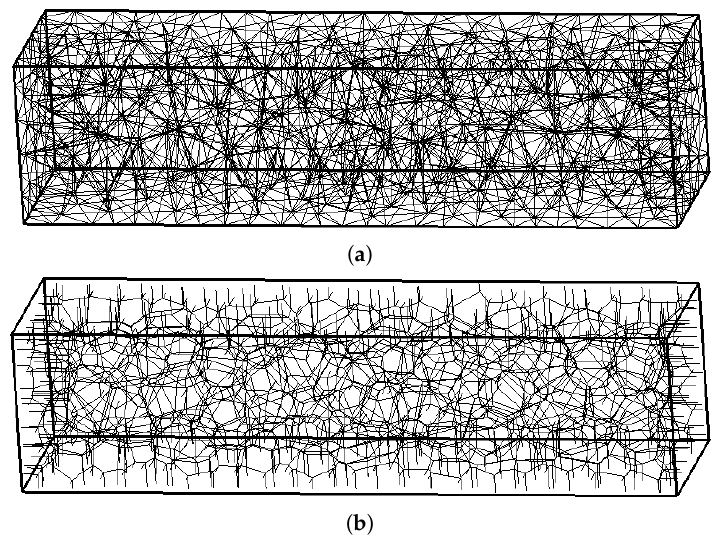
Figure 10. The coarse dual networks ( d min / L = 0.06) for ( a ) structural and ( b ) transport analysis.